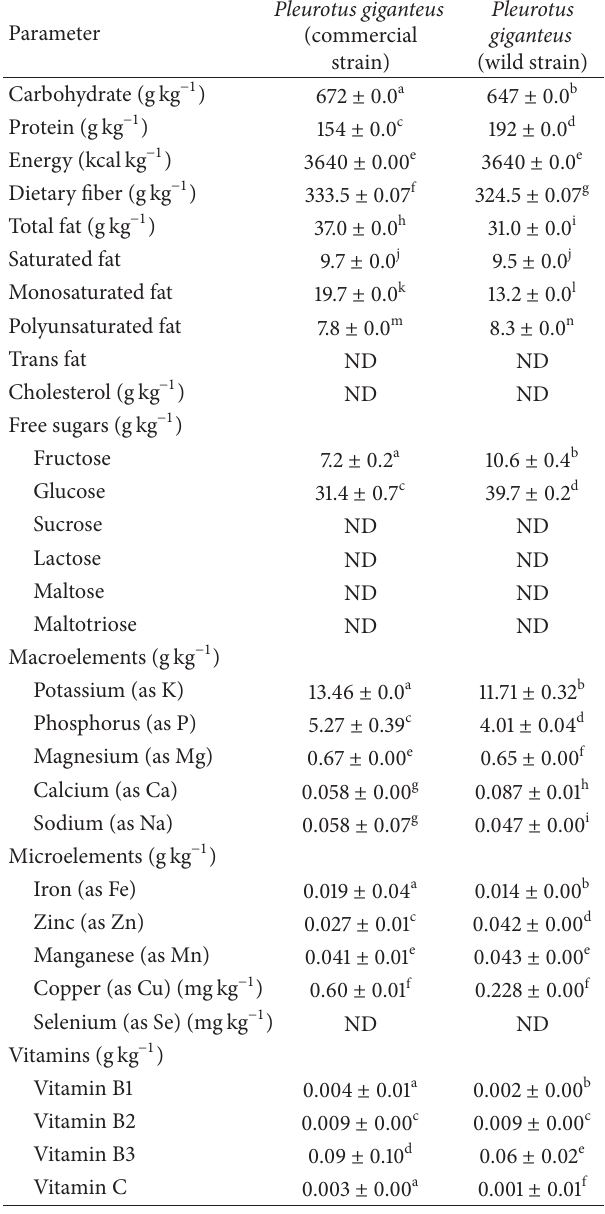
Table 1: Chemical compositions, sugars, macro- and microele- ments, and vitamins of commercial Pleurotus giganteus (KLU-M 1227) and wild P. giganteus (KLU-M